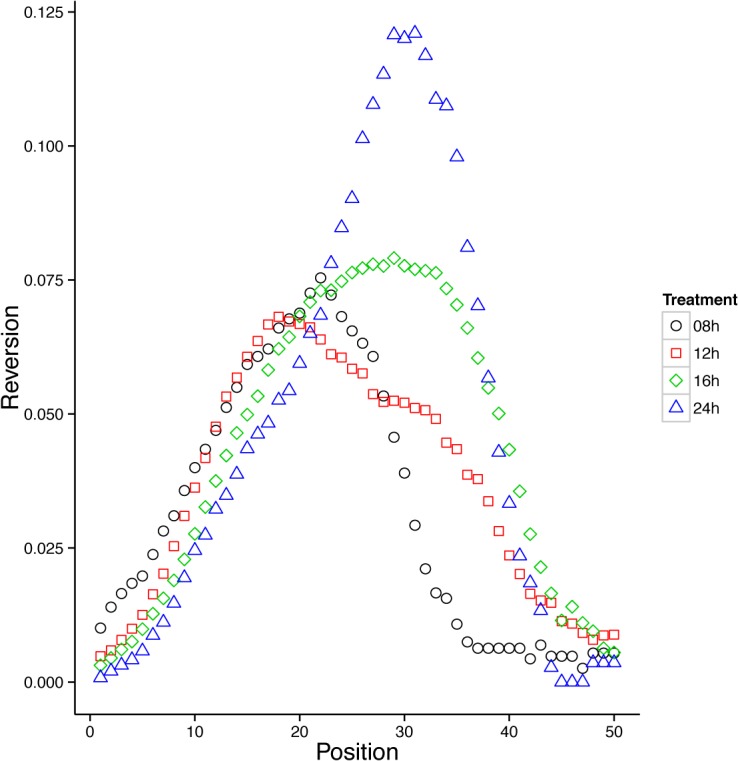
Floral reversion is more likely to occur earlier in development when days are short.To determine if reversion was equally likely for each position along the inflorescence from the oldest to the 50th flower, “weighted reversion frequencies” (see Methods for details) were calculated for each day length condition and plotted. Statistical significance between the positions of the peaks was calculated using ANOVA and Tukey post hoc testing. Statistically significant differences in peak positions for reversions were found only for the two extreme values of 8h and 24h of light.